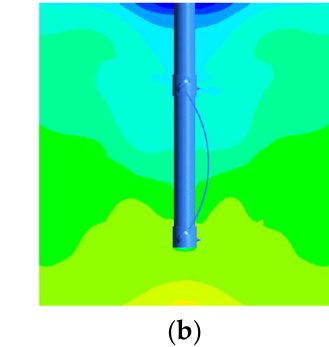
( b ) Figure 6. Contour plots of solid distribution for different impeller types. ( a ) DTBI; ( b ) DRFTBI. (Ro- tational speed: 120 rpm; solid loading: 30%; connection strap length: 1.2 H; plane: Z = 0 H, Z = 0.2 H, Z = 0.4 H, Z = 0.6 H, and Z = 0.8 H.) Figure 7. Histogram of solid distribution for different impeller types. (Rotational speed: 120 rpm; solid loading: 30%; connection strap length: 1.2 H S .)